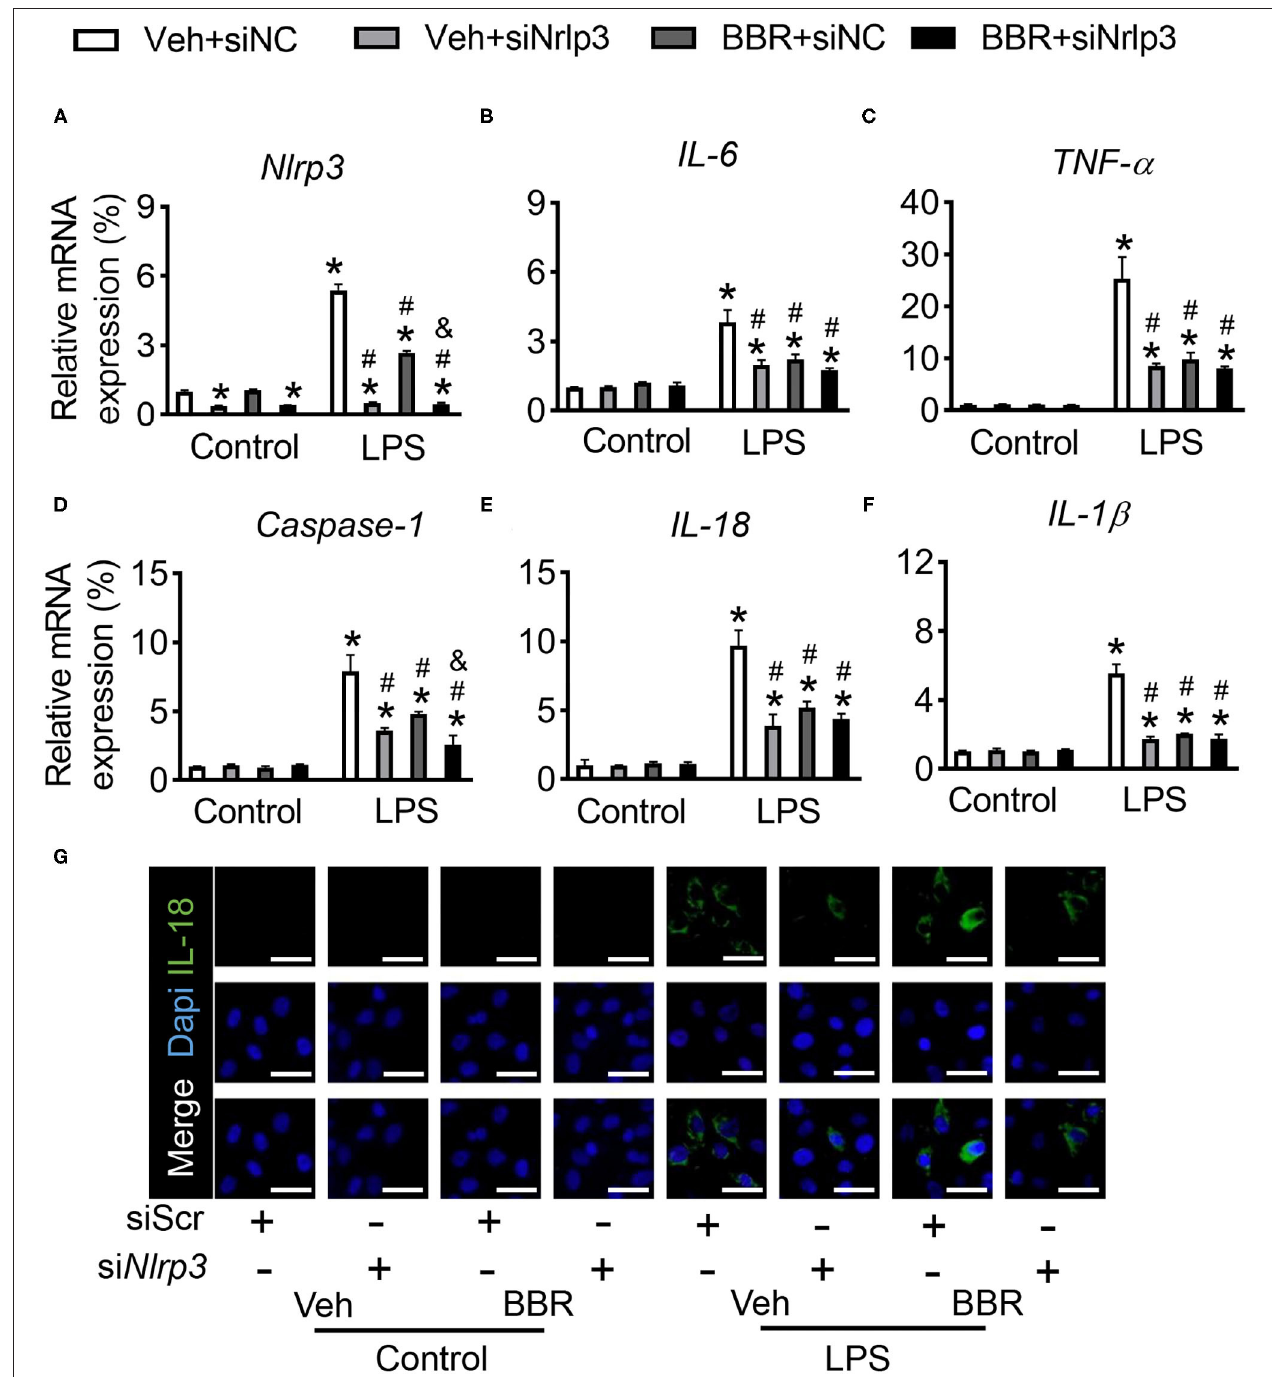
FIGURE 5 | Downregulation of Nlrp3 repressed the treatment role of BBR in HPMECs induced with LPS. HPMECs were transfected with Nlrp3 siRNA and stimulated with LPS. (A) The mRNA expression of Nlrp3 . (B,C) The mRNA expression of IL-6 and TNF- α . (D) The mRNA expression of Caspase-1 in vitro . (E,F) The mRNA expression of IL-1 β and IL-18 . (G) The immunofluorescence staining of IL-18 in HPMECs, scale bar = 50 µ m. Data were expressed as mean ± SD, n = 3 each group. Statistical significance is indicated as * P < 0.05 vs. the sham + vehicle groups, # P < 0.05 vs. the LPS + vehicle groups and & P < 0.05 vs. the LPS + BBR groups. transcriptional Nlrp3 or by Nlrp3-induced Nlrp3 Inflammasome First, we detected the efficiency of siNlrp3 and found that Complex or both two pathways are not clear. Hence, we the expression of Nlrp3 was significantly decreased by used siRNA of Nlrp3 to study the underlying mechanism. siNlrp3 whether stimulated with LPS or not ( Figure 5A